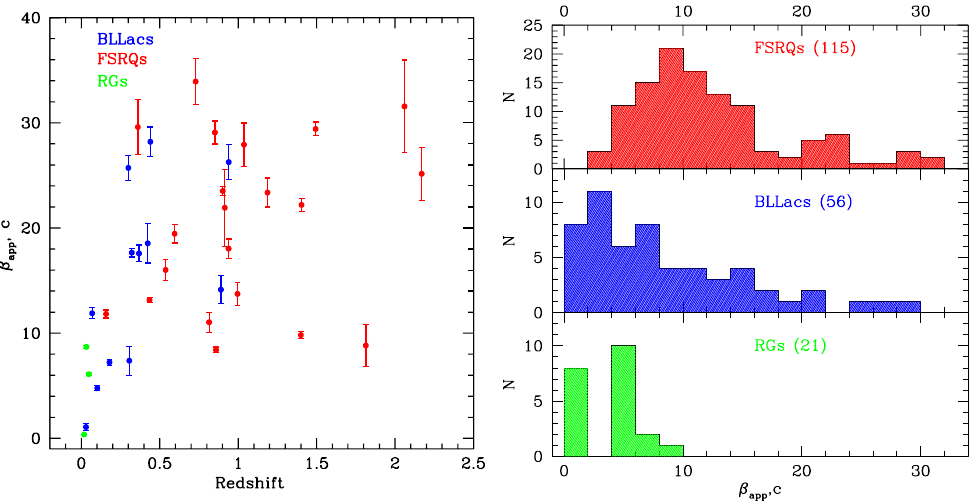
Figure 3. Left: Maximum apparent speed vs. redshift for each source in the sample; Right: Distributions of apparent speed of all moving knots in the sample, separately for FSRQs, BLLacs, and